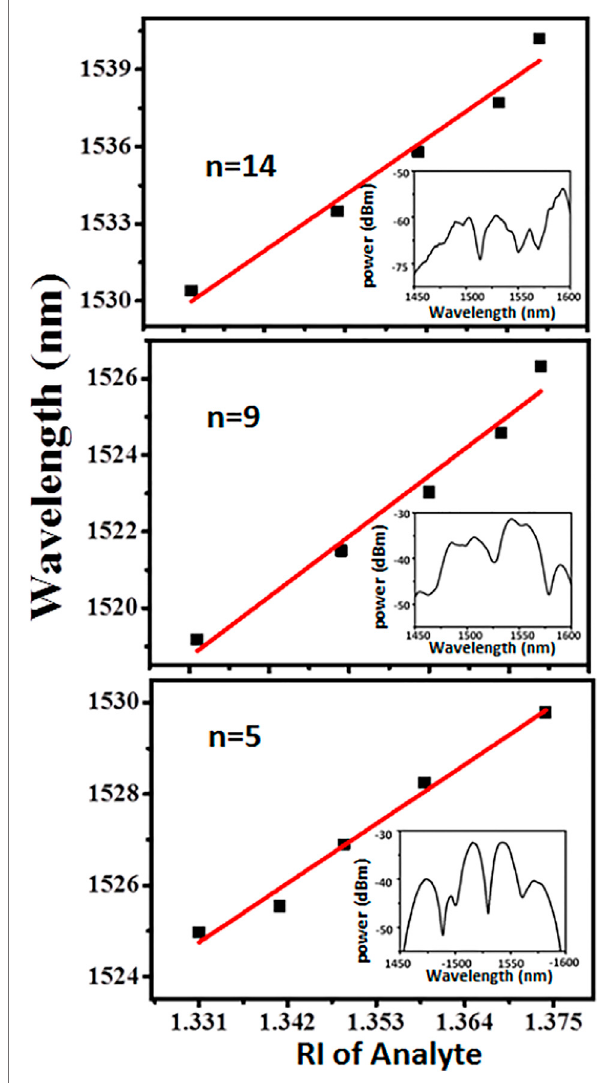
FIGURE 4 | Shift in interference pattern with RI of chemicals. The black squares show the experimental data, and the red lines show the linear fi t.